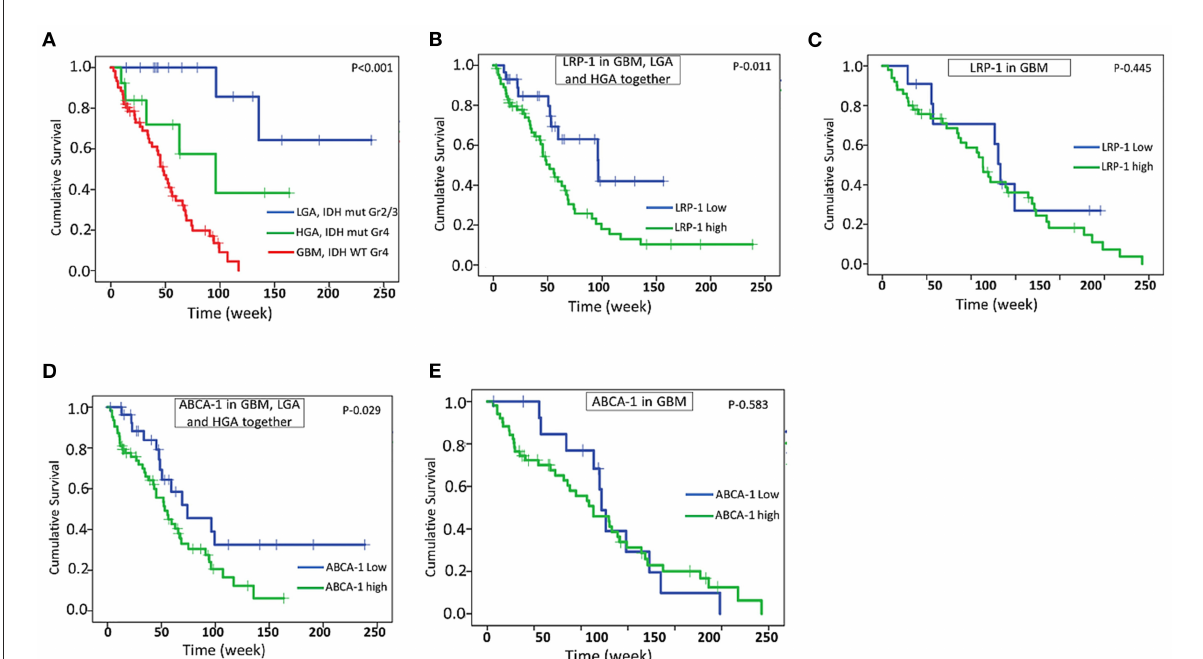
FIGURE6 Survival analysis. Kaplan -Meier analysis showing overall survival (OS) in GBM and other IDH mutated astrocytic tumor (HGA and LGA) (A) , correlation of LRP-1 expression with OS in all astrocytic tumor and GBM together (B) , correlation of LRP-1 expression with OS in GBM separately (C) , correlation of ABCA-1 expression with OS in all astrocytic tumor and GBM together (D) , correlation of ABCA-1 expression with OS in GBM separately (E) . The p -values mentioned in the figure are derived from log-rank